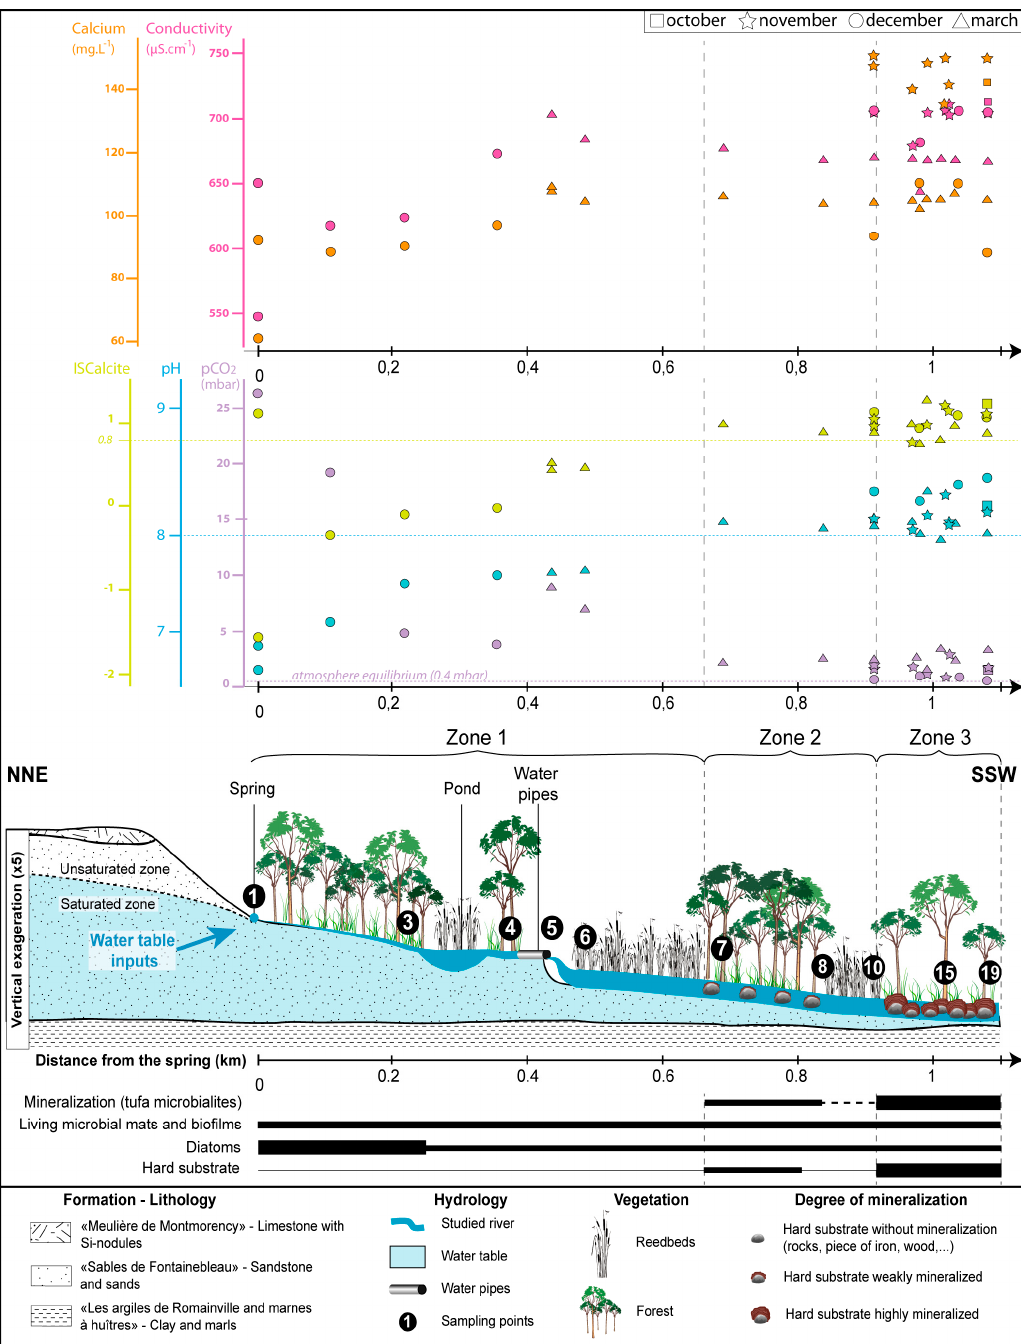
concentration; conductivity; the color of symbols corresponds to the color of the axes of the various